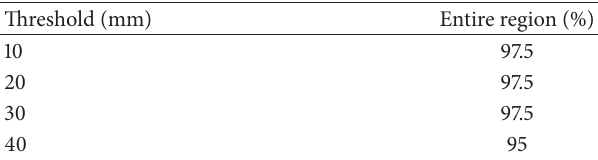
Table 2: Confidence level of positive trends of the frequency of rainfalls over the indicated